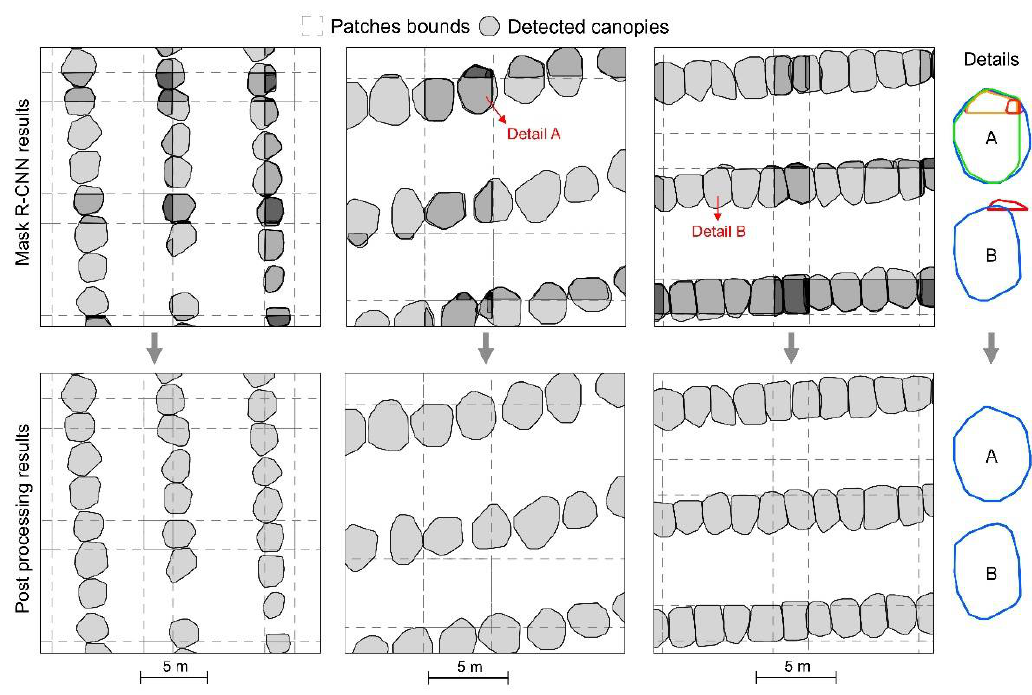
Figure 8. Results of unsupervised merge process.